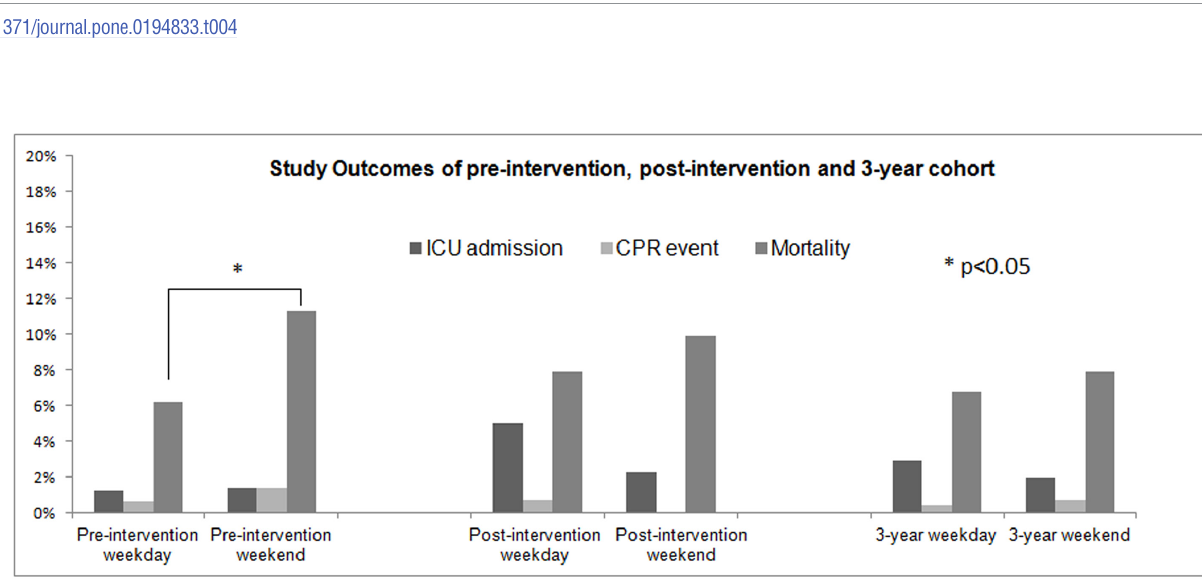
Data are expressed as mean ± standard deviation or number of cases (%).